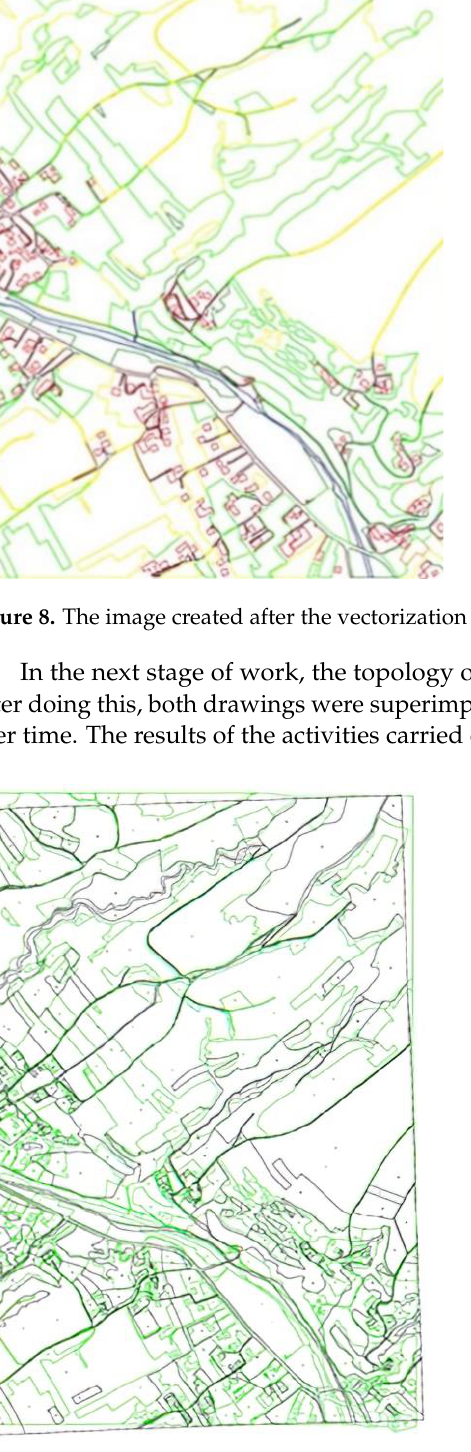
Figure 9. The image that emerged after the transformations